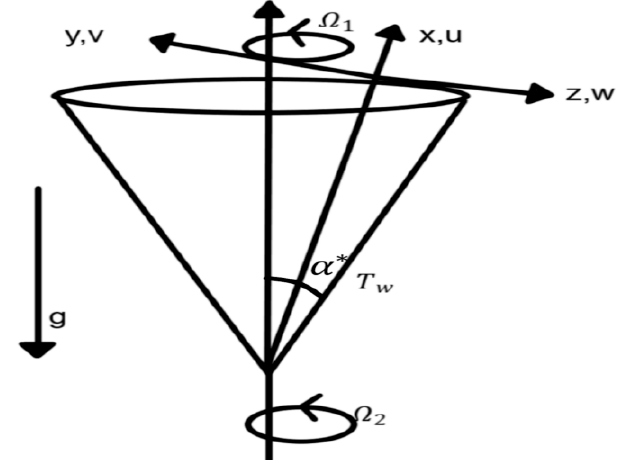
Figure 1. Physical configuration of rotating system.